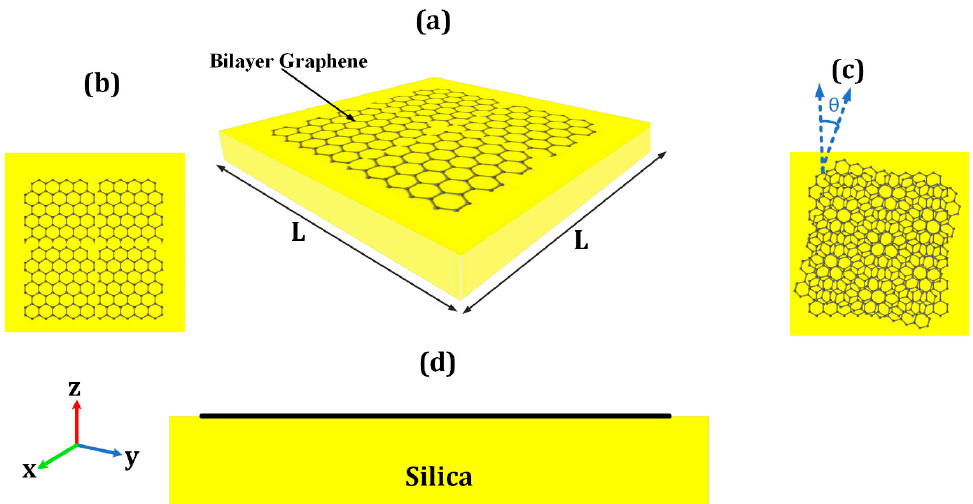
Figure 1. Graphene twistronics: ( a ) three-dimensional model of bilayer graphene placed on silica substrate without twist; ( b ) bilayer graphene without twist placed on silica substrate (top view); ( c ) bilayer graphene with twist angle θ ° placed over silica substrate (top view); ( d ) bilayer graphene place on silica substrate (side view), L = 25 µm.